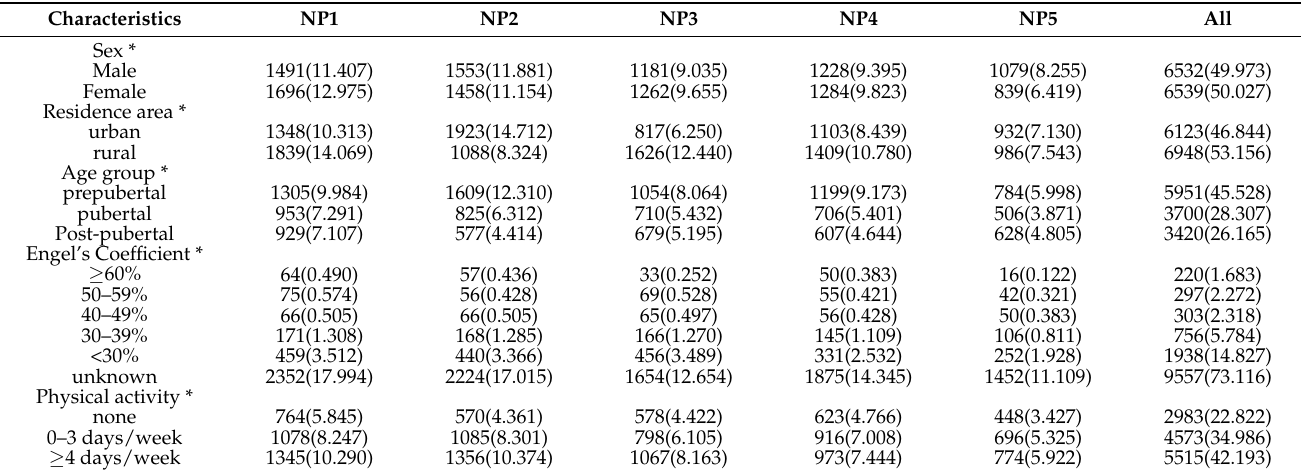
Table 2. The basic characteristics [n (%)/Median (IQR)] of five